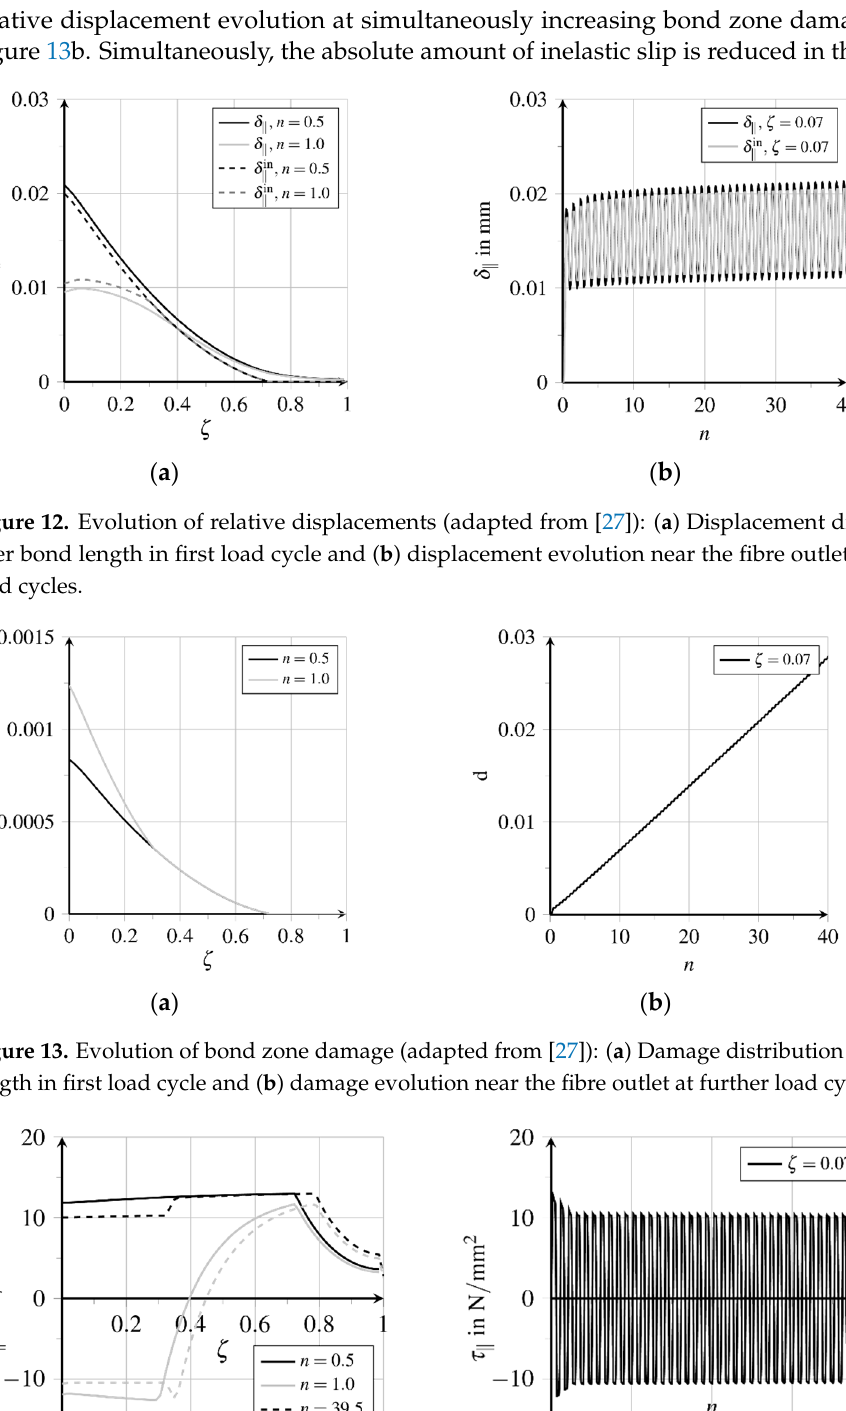
Figure 13. Evolution of bond zone damage (adapted from [27]): ( a ) Damage distribution over bond length in first load cycle and ( b ) damage evolution near the fibre outlet at further load cycles.